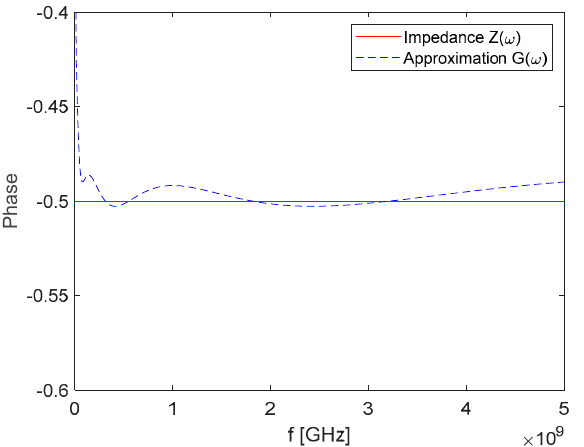
Figure 3. Amplitude of the impedance Z ( ω ) and the rational approximation function G ( ω ).